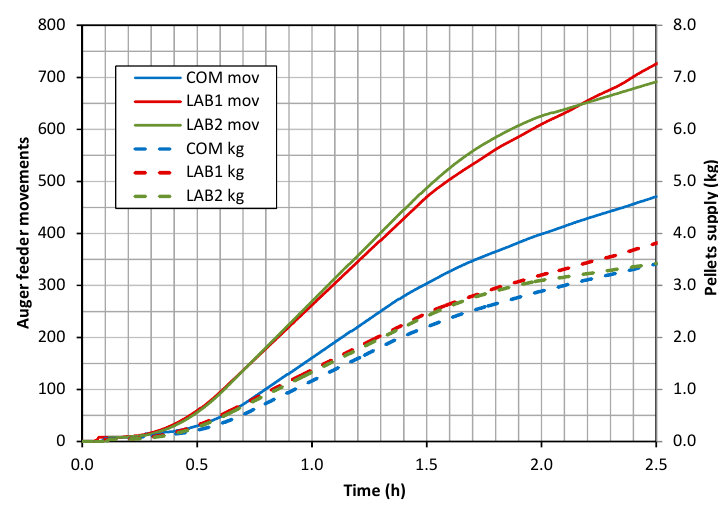
Figure 4. Performance of the auger feeder during combustion tests.